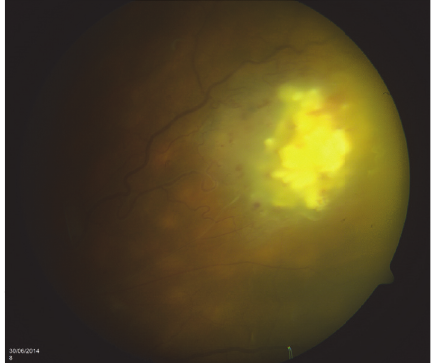
Figure 1: Colour fundus of the right eye revealing creamy retinal lesions in keeping with birdshot retinochoroiditis.